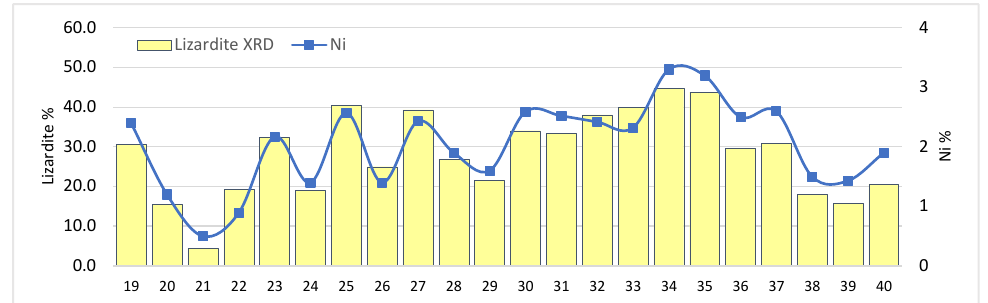
Figure 11. Comparison of the amount of lizardite (XRD) and the nickel content (XRF) in the saprolitic samples of the profile.